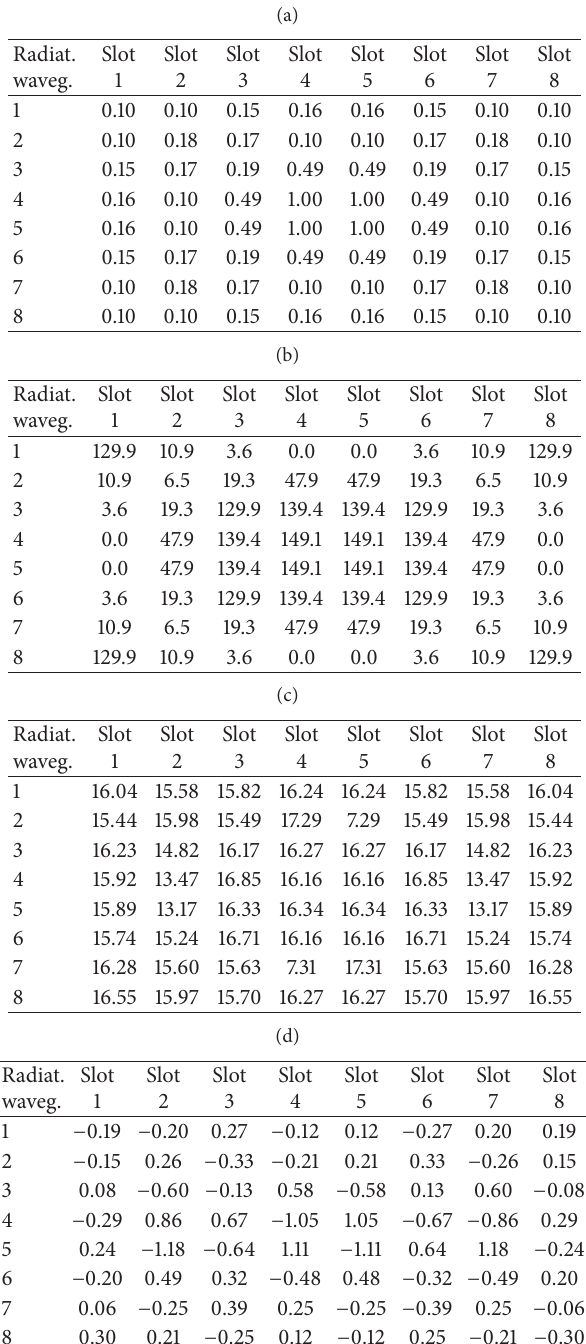
Table 1: (a) Required normalized amplitude of slots excitations for the 8 × 8 planar array with a circular radiation pattern. (b) Required phase (degrees) of slots excitations for the 8 × 8 planar array with a circular radiation pattern. (c) Designed slots lengths (mm) for the 8 × 8 planar array with a circular radiation pattern. (d) Designed slots offsets (mm) for the 8 × 8 planar array with a circular radiation